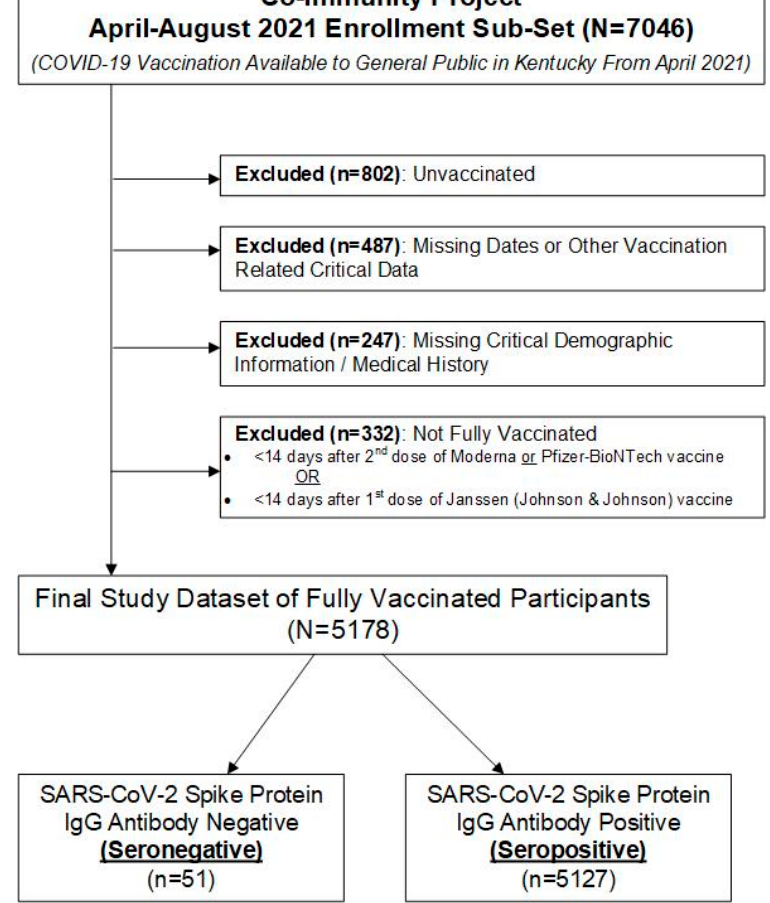
Figure 1. CONSORT flow diagram of dataset identification.